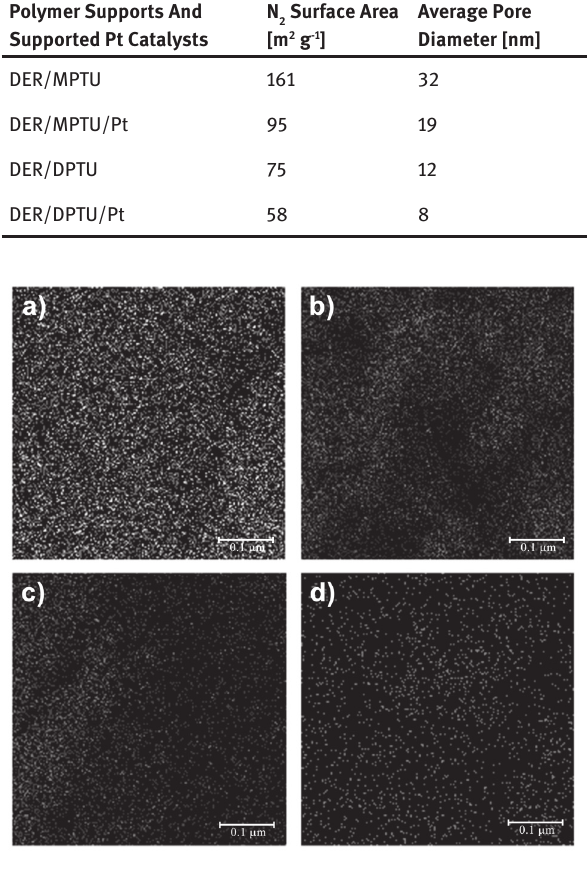
Figure 5: SEM-EDX micrographs of the surface of the (a) DER/ MPTU/Pt/before hydrogenation reaction, (b) DER/MPTU/Pt/after hydrogenation reaction, (c) DER/DPTU/Pt/before hydrogenation reaction and (d) DER/DPTU/Pt/ after hydrogenation